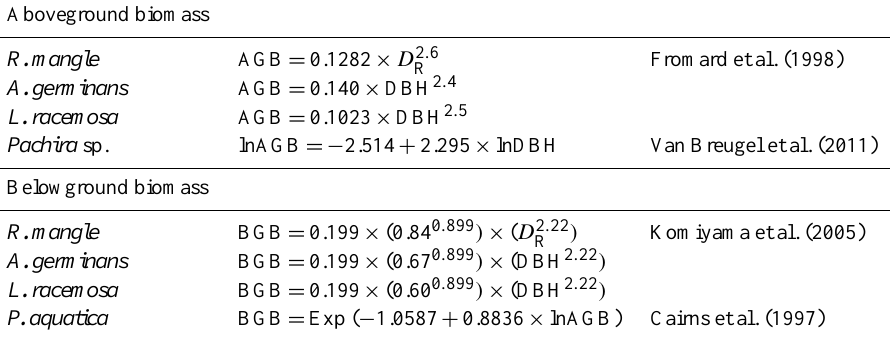
Table 2. Allometric equations used to calculate aboveground and belowground biomass (kg) of mangrove and peat swamp trees. AGB – aboveground biomass; BGB – belowground biomass; D R – diameter above highest prop root (cm); DBH – diameter at breast height. Wood density (gcm − 3 ) values used for calculating belowground biomass were obtained from Chave et al. (2009) and Zanne et al.